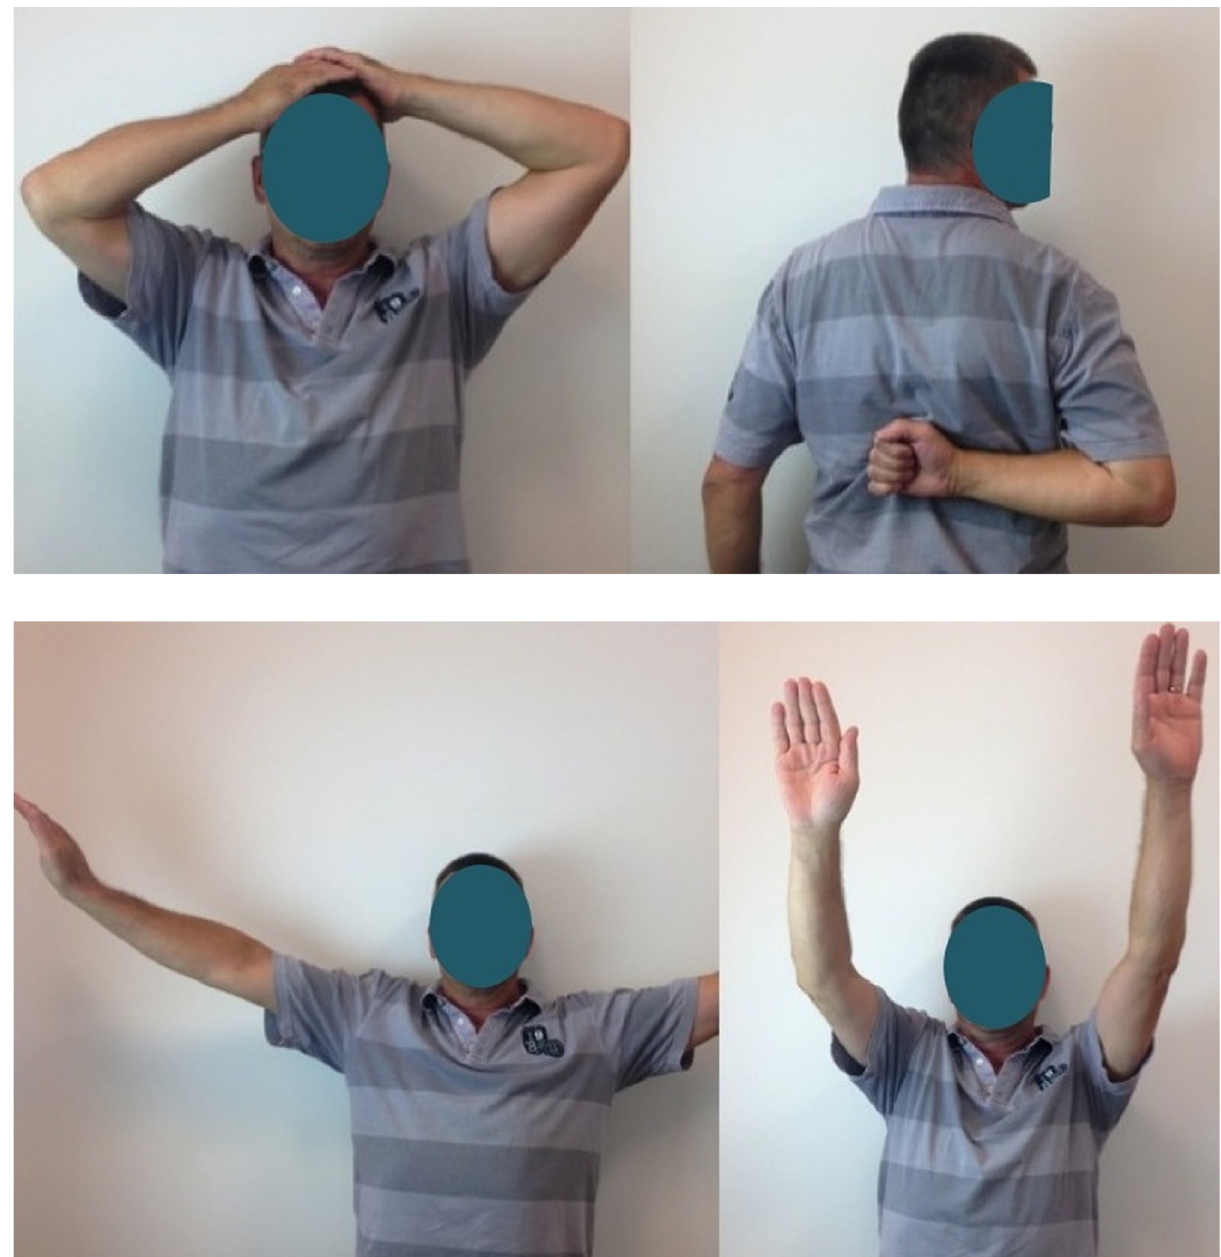
Figure 6. Functional results at 26 months of follow-up with a Constant score = 81 (90 if